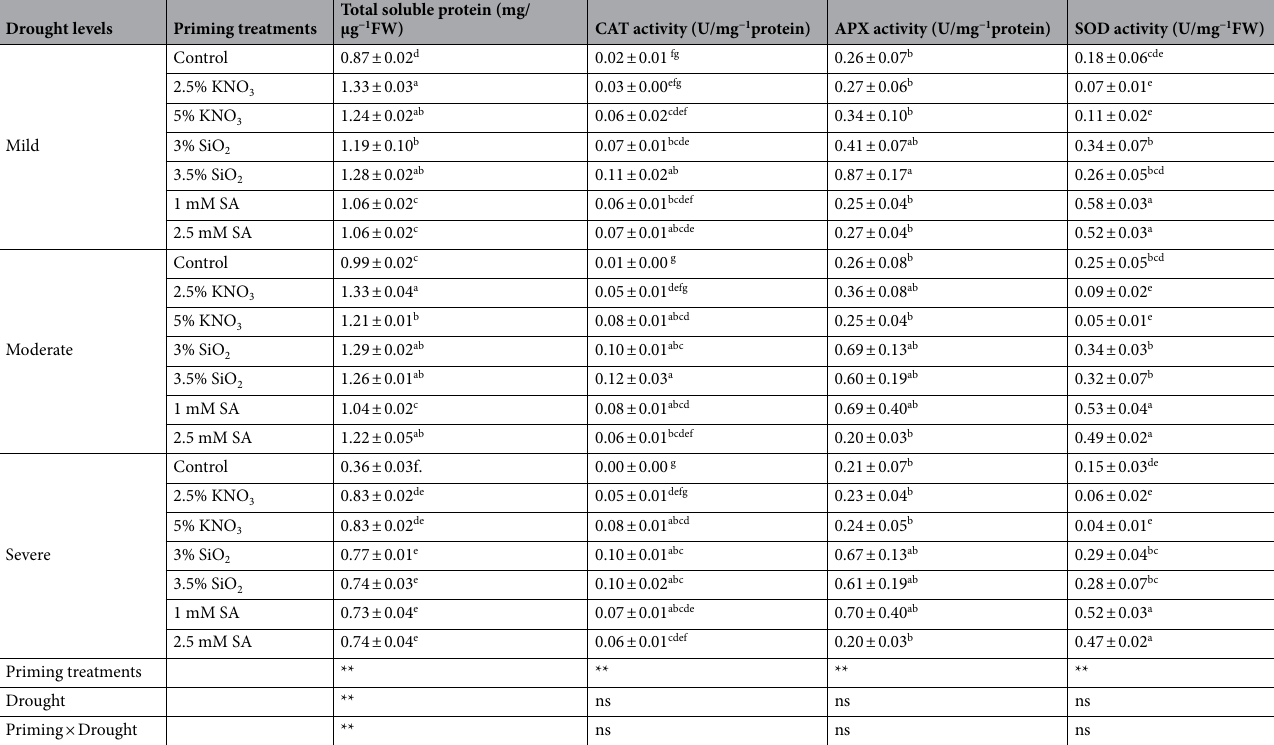
Table 4. Total soluble protein content, CAT, APX and SOD activities of rice seedlings primed with KNO 3 , SiO 2 and SA under drought conditions. Mean values ± SE in the same column followed with similar letters are not significantly different according to DMRT ( P ≤ 0.05); SE Standard error of the mean, CAT Catalase, APX Ascorbate peroxidase, SOD Superoxide dismutase, *Significant at 5% level of probability, **Significant at 1% level of probability, ns Not